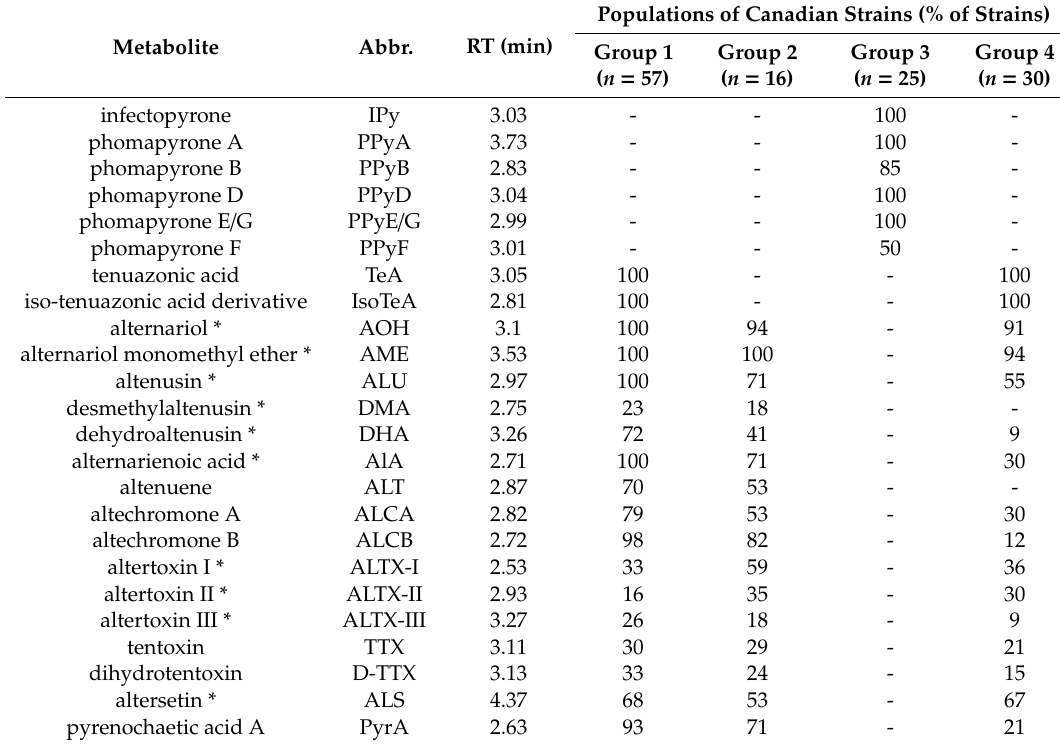
Figure 2. Substrate distribution within groups assigned by k -means clustering. Table 1. Known Alternaria metabolites detected in 128 Canadian strains of Alternaria separated by their population, and percentage of isolates producing them.